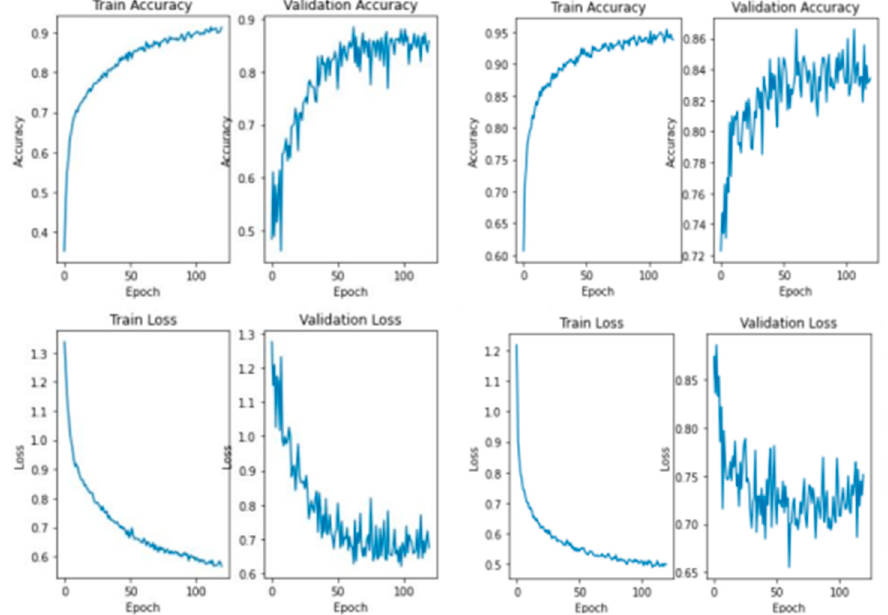
Figure A3. Training progress of the convolution-based models–simple Convolution ( left ) and Xcep- tion ( right ).